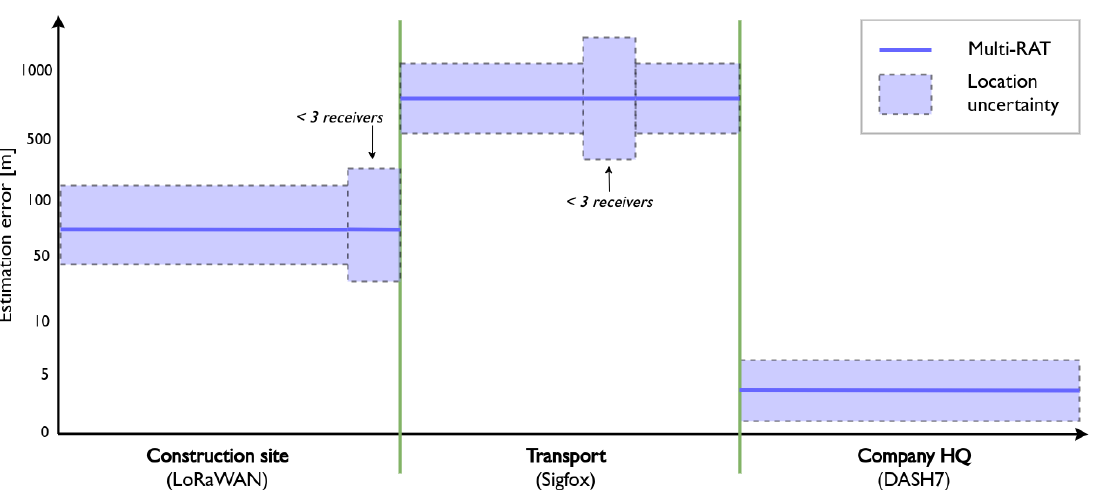
Figure 6. The expected location accuracy and reliability of the construction tool use case. GNSS is omitted from this figure, as the tracker does not contain a GNSS receiver. The expected estimation errors are based on results from related work in Section 2, and are displayed on a logarithmic